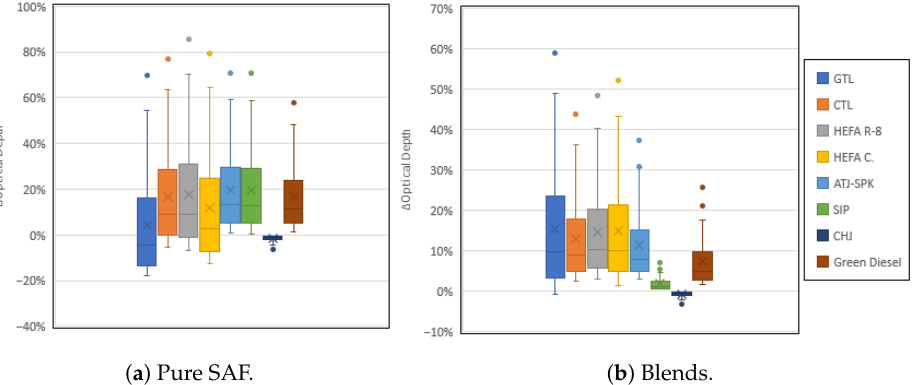
Figure 14. RDs in peak optical depths for ambient relative humidities at formation in the range of 41% to